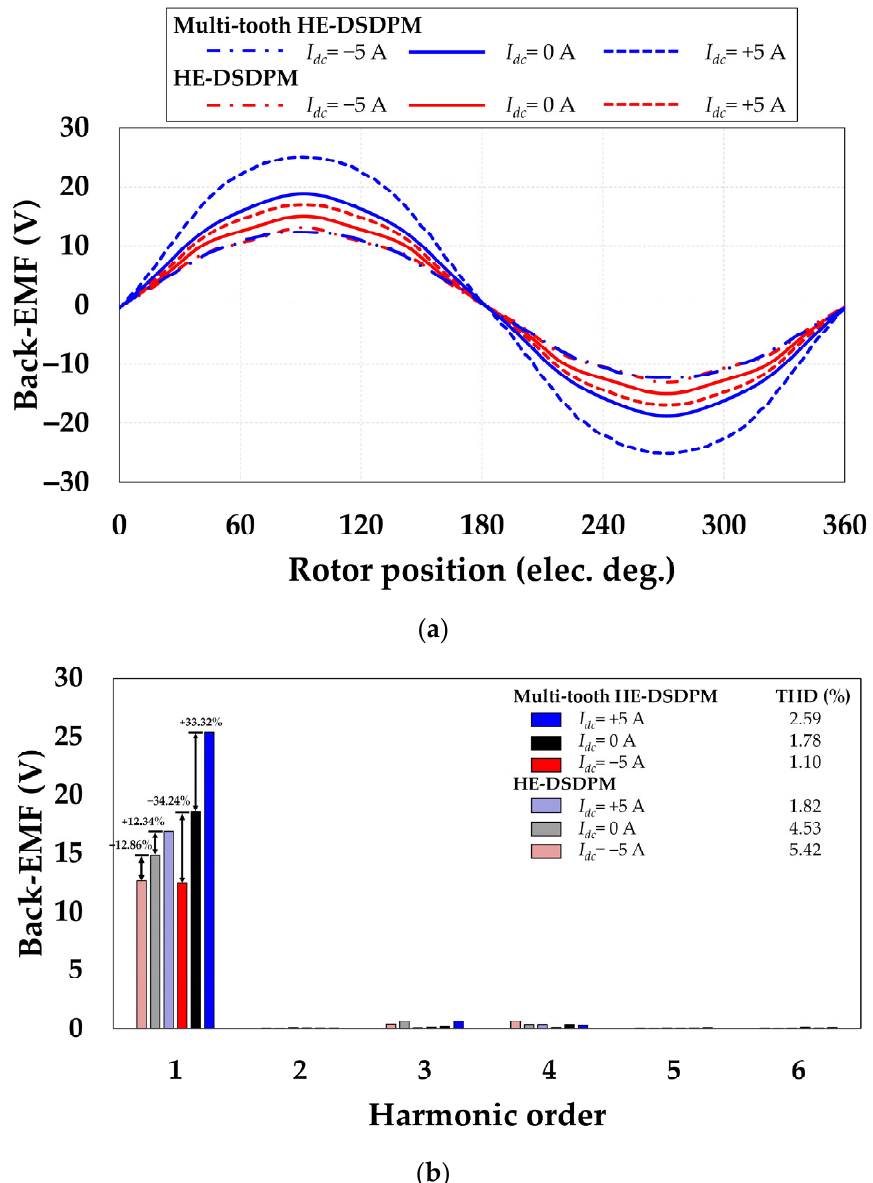
Figure 8. Open ‐ circuit back ‐ EMF of the proposed HE ‐ DSDPM with various I dc : ( a ) waveform and Figure 8. Open-circuit back-EMF of the proposed HE-DSDPM with various I dc : ( a ) waveform and ( b ) harmonic spectra. ( b ) harmonic